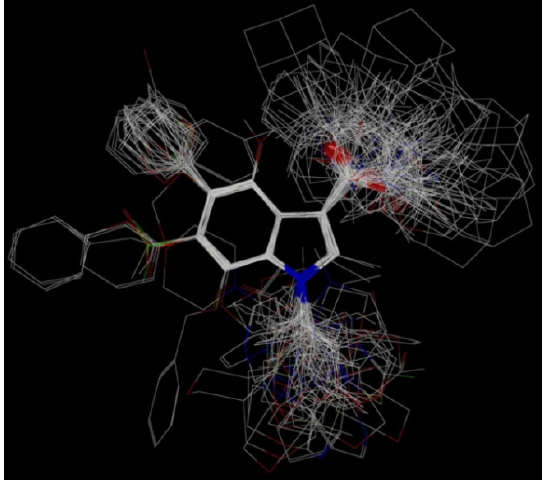
Figure 4. The superimposed structure of all compounds used in the CoMFA models.